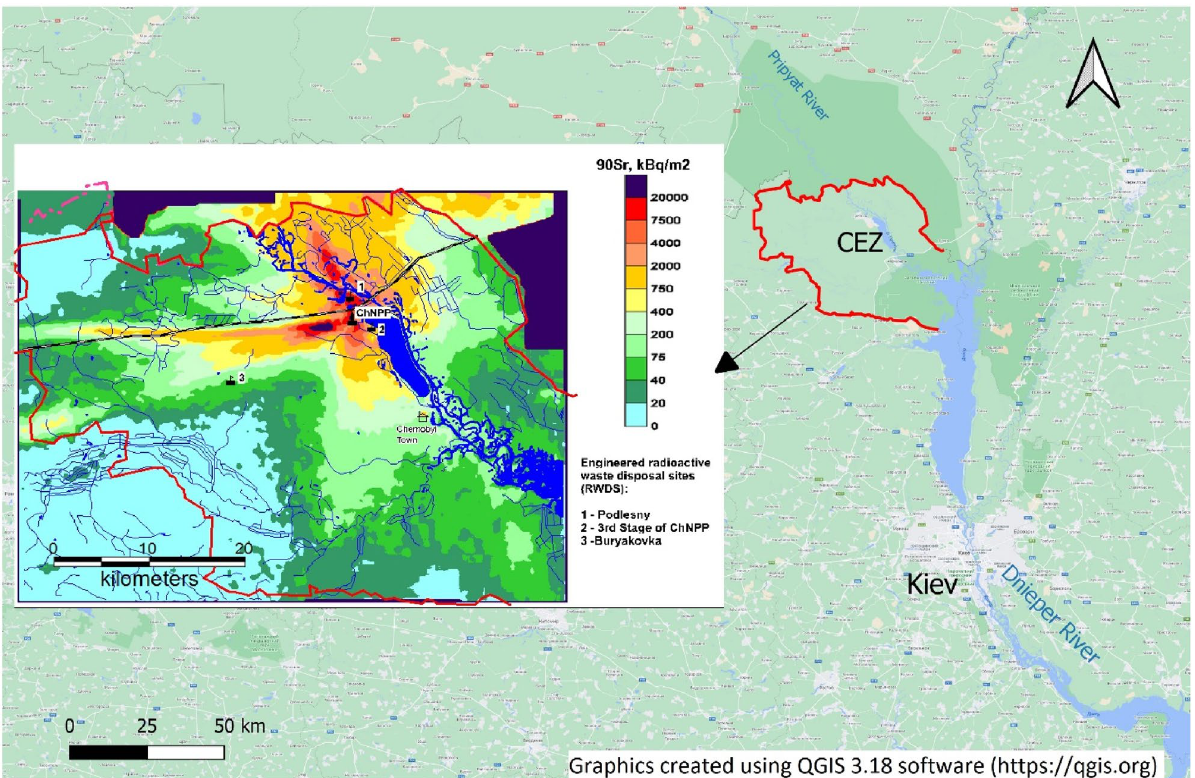
Figure 1. Location of the Chernobyl Exclusion zone (CEZ). Surface contamination map by 90 Sr in the CEZ (as of 1997) is based on data of 35